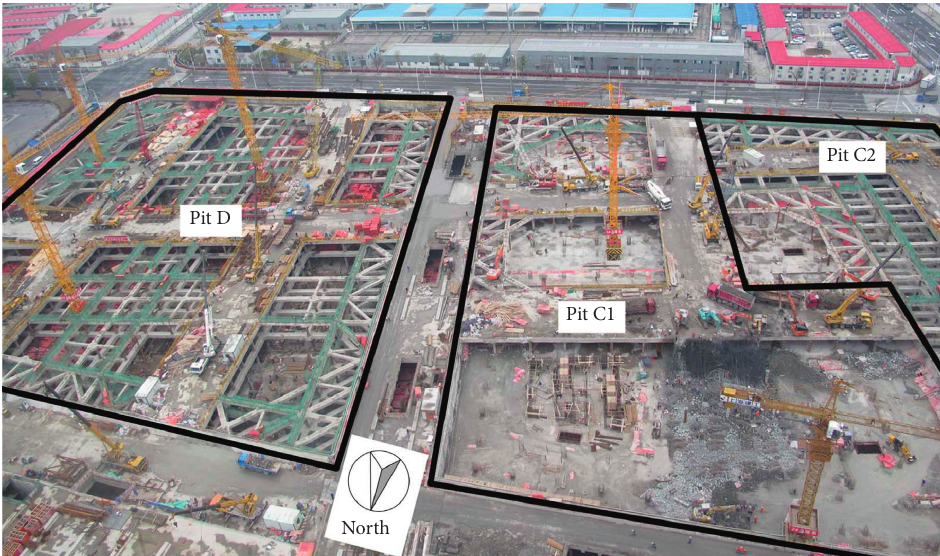
Figure 6: Photo of the construction fields of pits C1 and D at Shanghai expo.